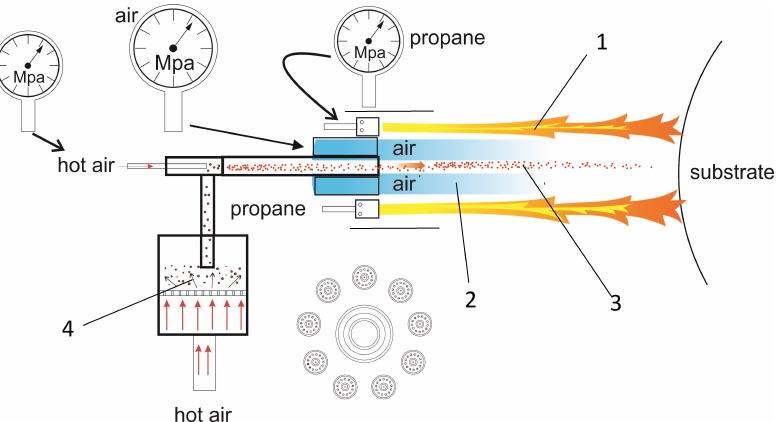
Figure 2. Scheme of the experimental setup for spraying polymeric thermoplastic